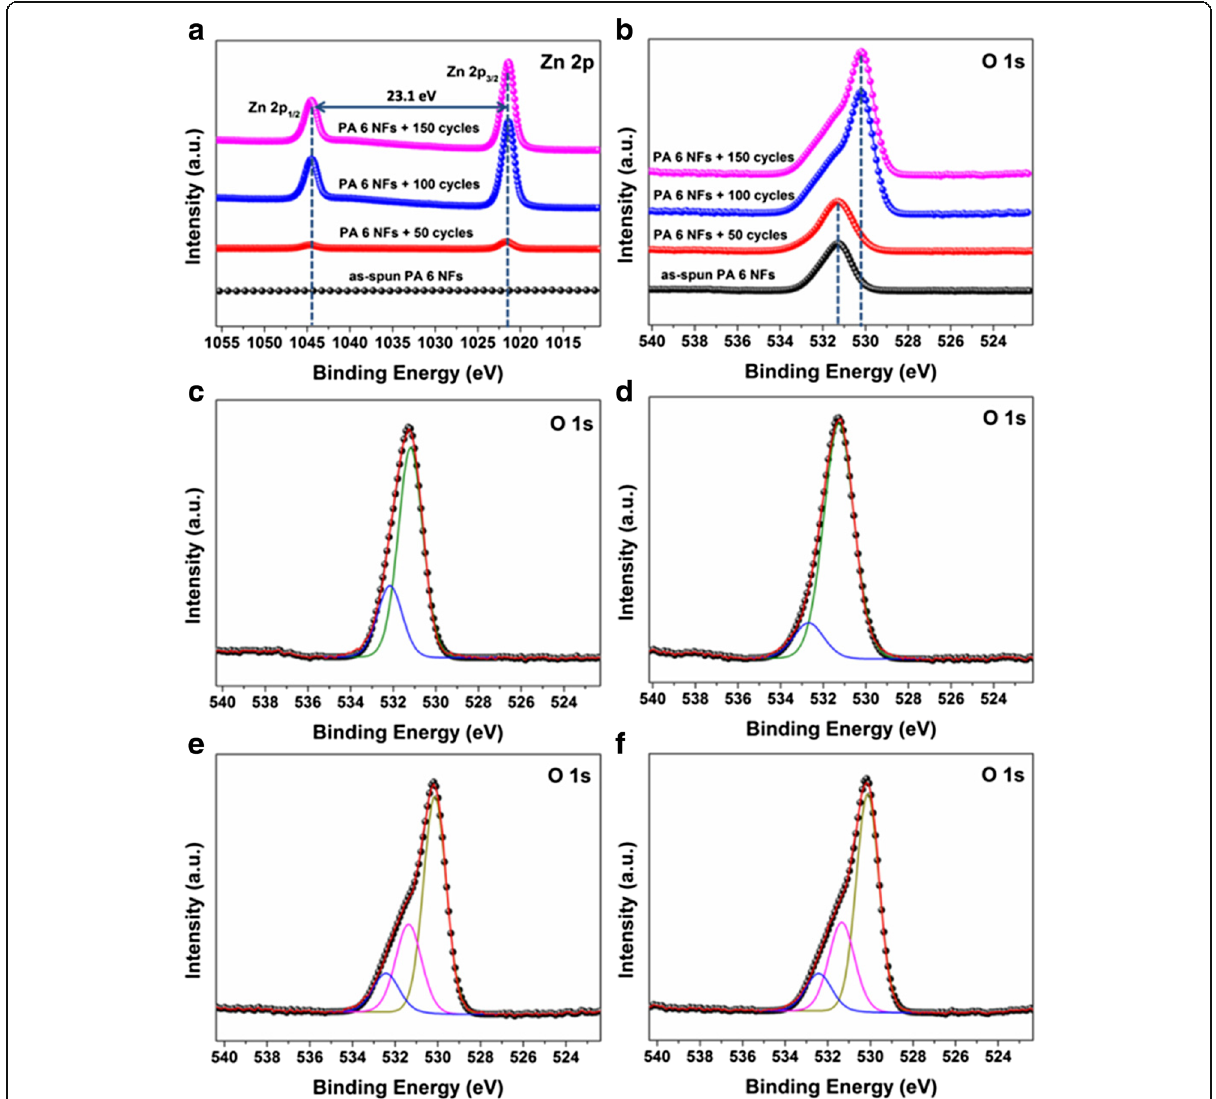
Fig. 2 XPS of the as-spun PA 6 NF and ALD ZnO coating NFs. a Zn 2p core. b O 1s core. The deconvolution of O 1s core c for as-spun PA 6 NF. d 50, e 100, and f 150 cycles of ALD ZnO coating